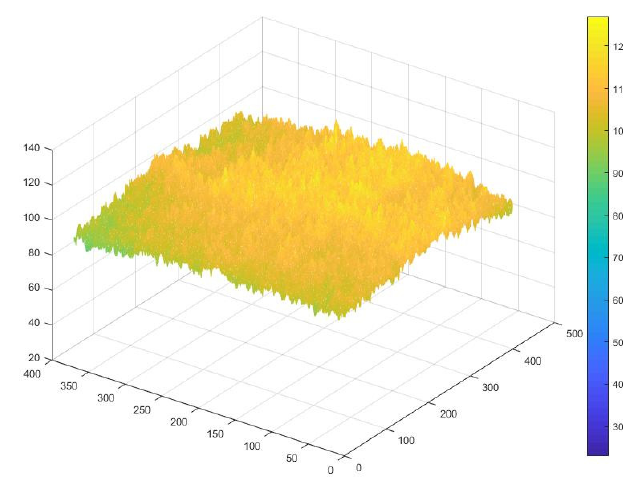
Figure 2. Light spot intensity distribution after homogenization.